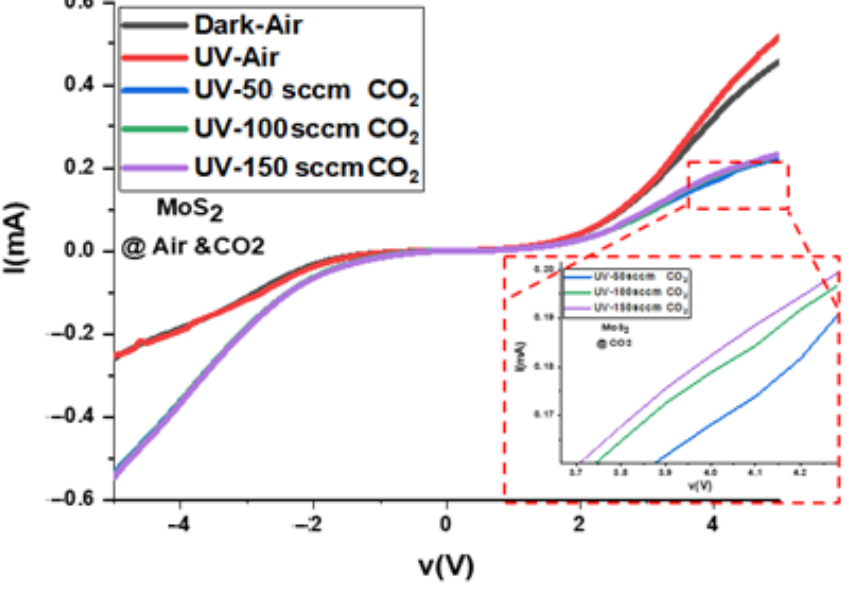
Figure 8. I-V characteristic of MoS 2 in the absence of light and UV illumination conditions under air and CO 2 .